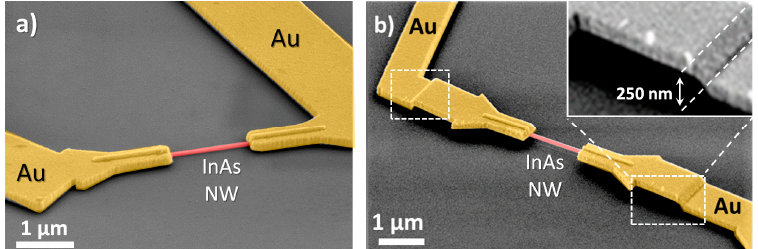
Figure 2. False color scanning electron micrograph of supported ( a ) and suspended ( b ) InAs nanowire-based devices, on a SiO 2 /p++Si substrate. In both images, the nanowires are red colored, while Ti/Au contact electrodes are yellow-colored. In device ( a ) the NW is in contact with the substrate, while in the device ( b ), it is suspended at about 250 nm over the substrate.